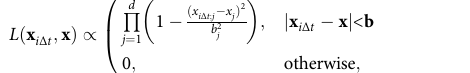
= _ S ratio. The ss TUR